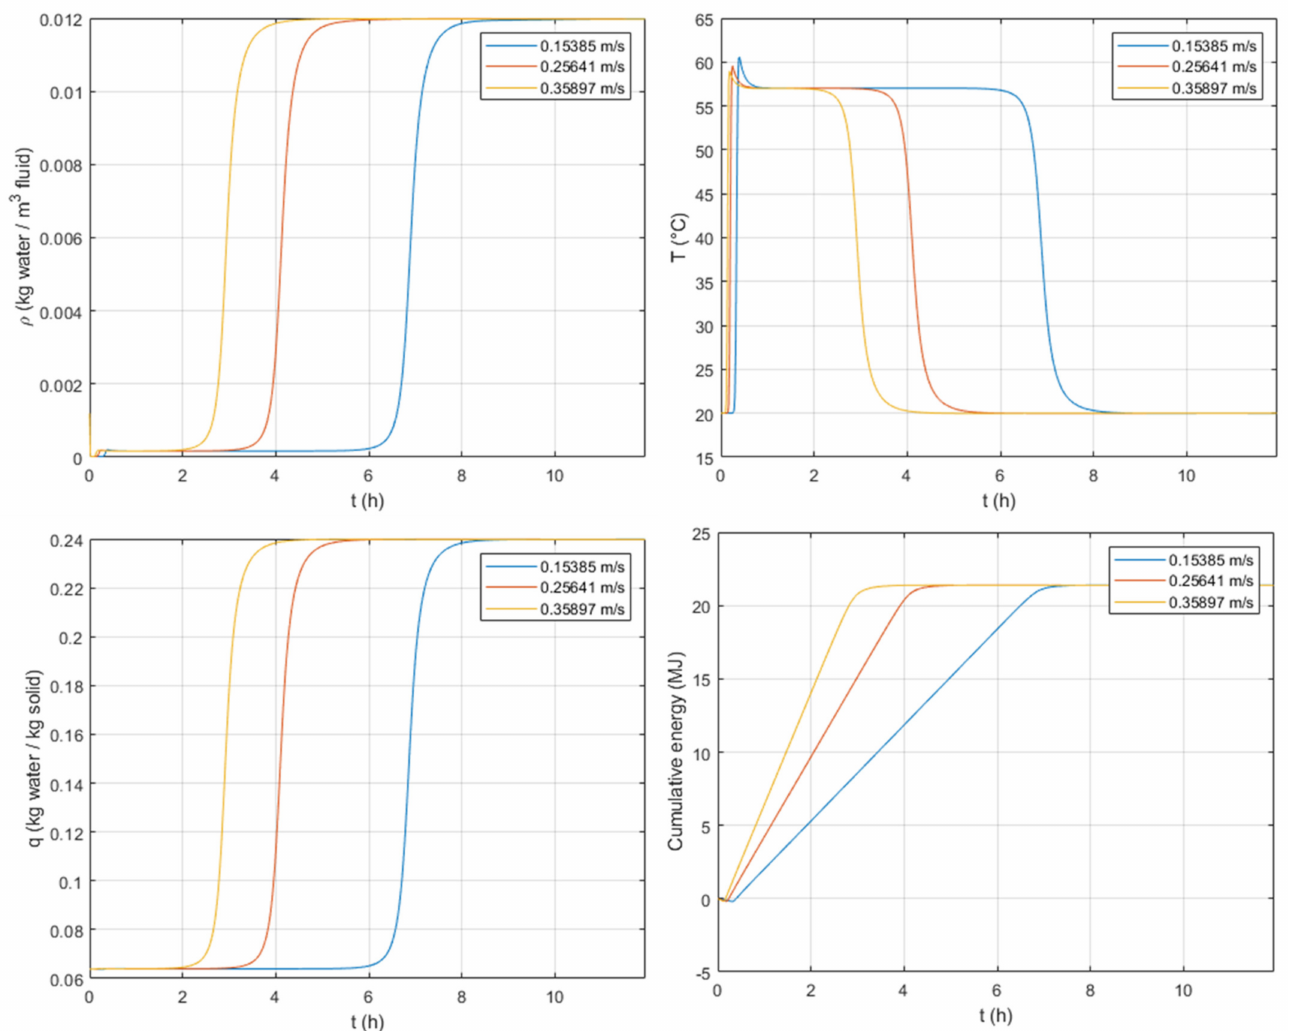
Figure 10. Parametric analysis of the inlet interstitial velocity and study of the evolution with time of water fluid concentra- tion, fluid temperature, water adsorbed concentration, and cumulated heat at the column